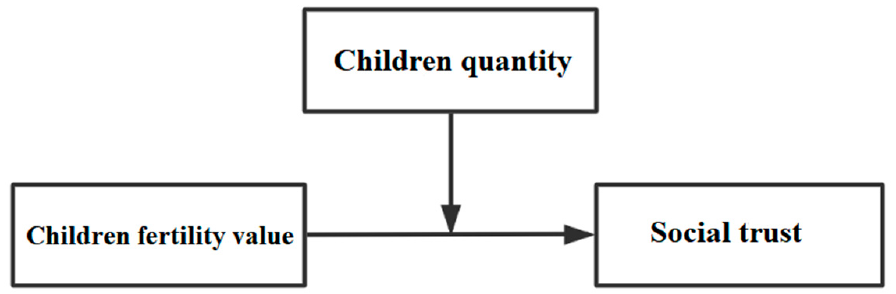
Figure 2. The children quantity moderating effect model of fertility value and social trust.